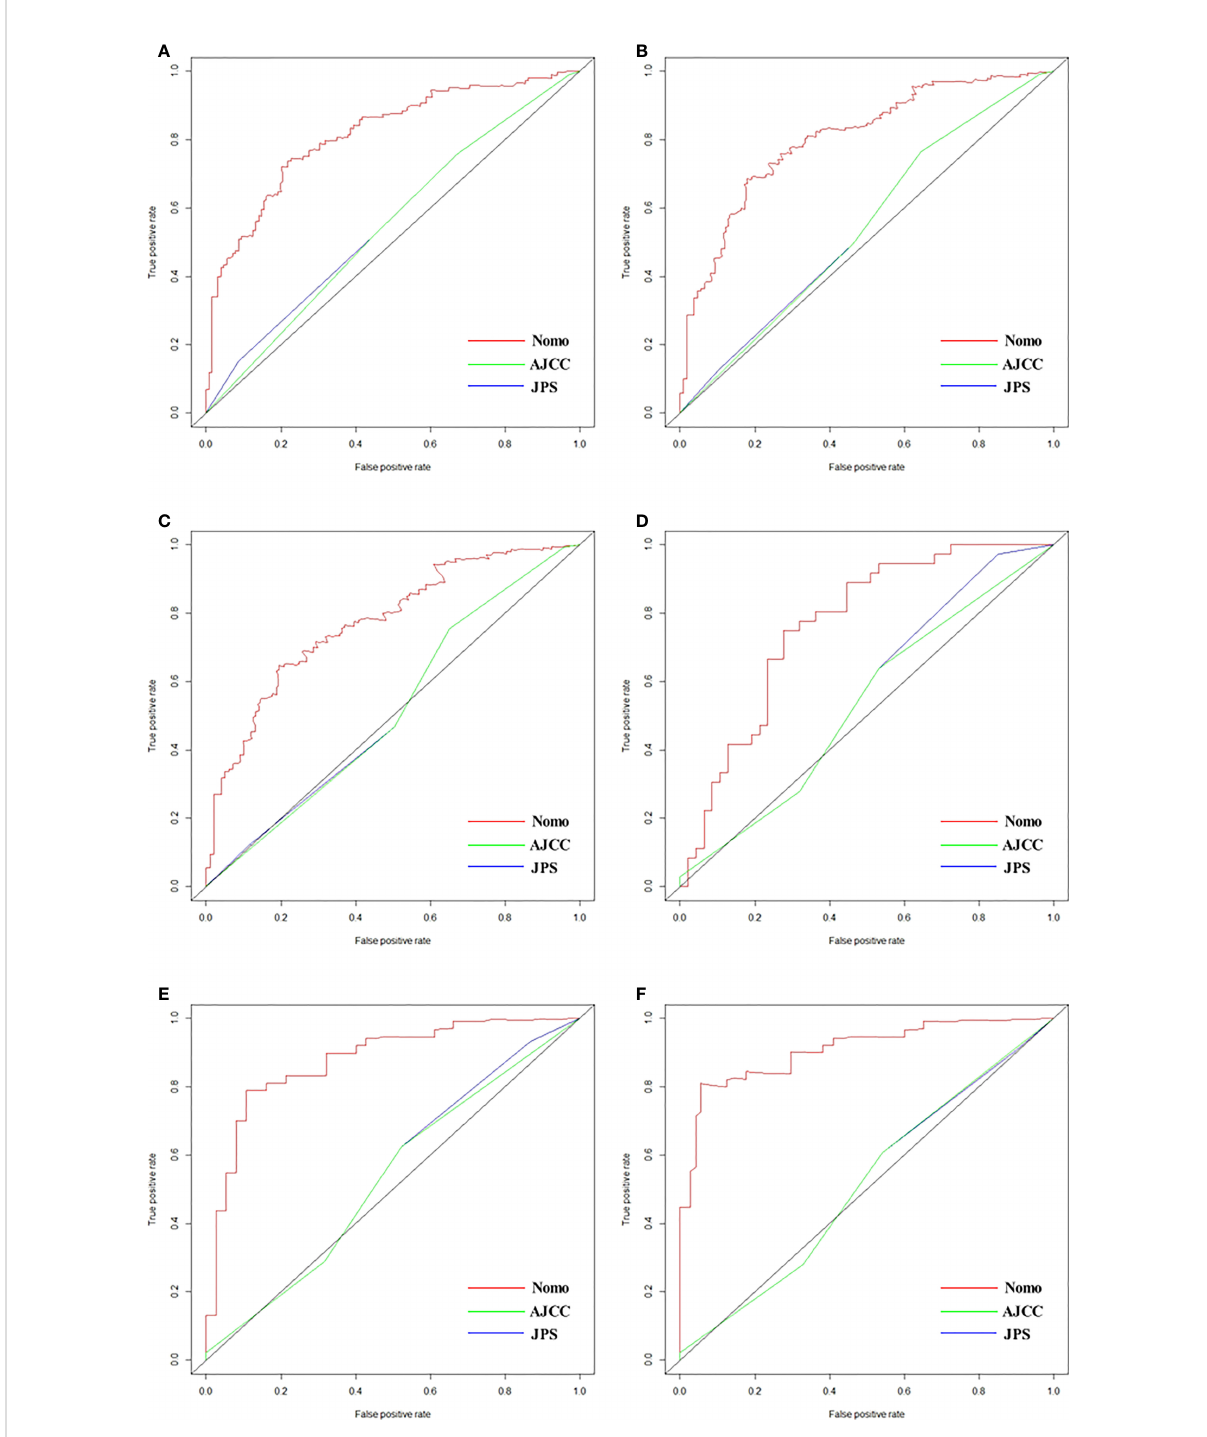
FIGURE 4 ROCs of nomogram, AJCC and JPS for predicting liver metastasis-free survival at 1 year (A) , 2 years (B) and 3 years (C) in the training cohort, and those at 1 year (D) , 2 years (E) and 3 years (F) in validation cohorts,